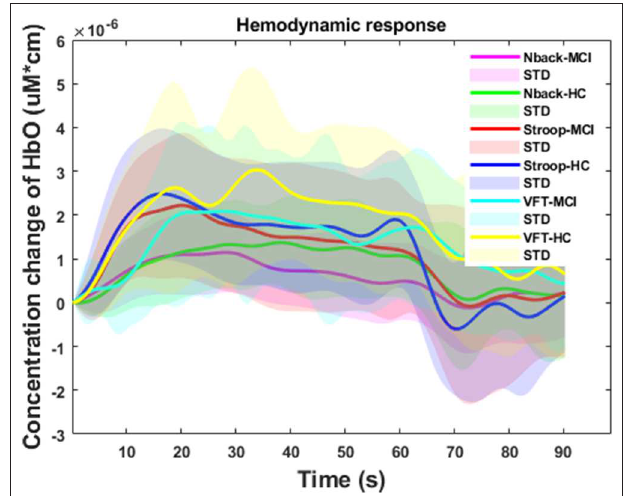
FIGURE 7 | Temporal feature of the 1 HbO for three mental tasks (i.e., N -back task, Stroop task, and verbal fluency task) for mild cognitive impairment and healthy control groups,